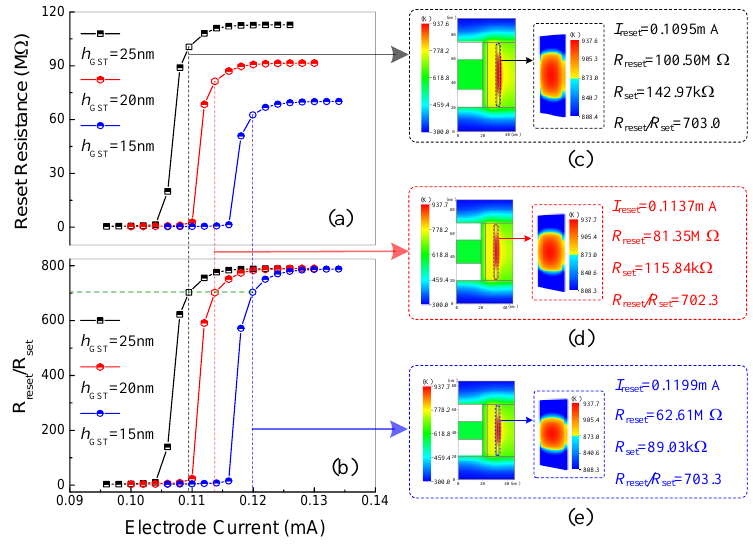
Figure 8. ( a ) Reset resistance and ( b ) resistance ratio of cells with different h GST values. ( c – e ) The temperature distributions on symmetrical cross-sections and 3-D GST strips at t = 1.8